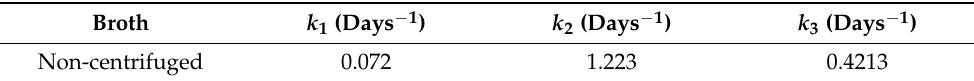
Table 2. Kinetic constants calculated from experimental data. Broth k 1 (Days − 1 ) k 2 (Days − 1 ) k 3 (Days − 1 ) Non-centrifuged 0.072